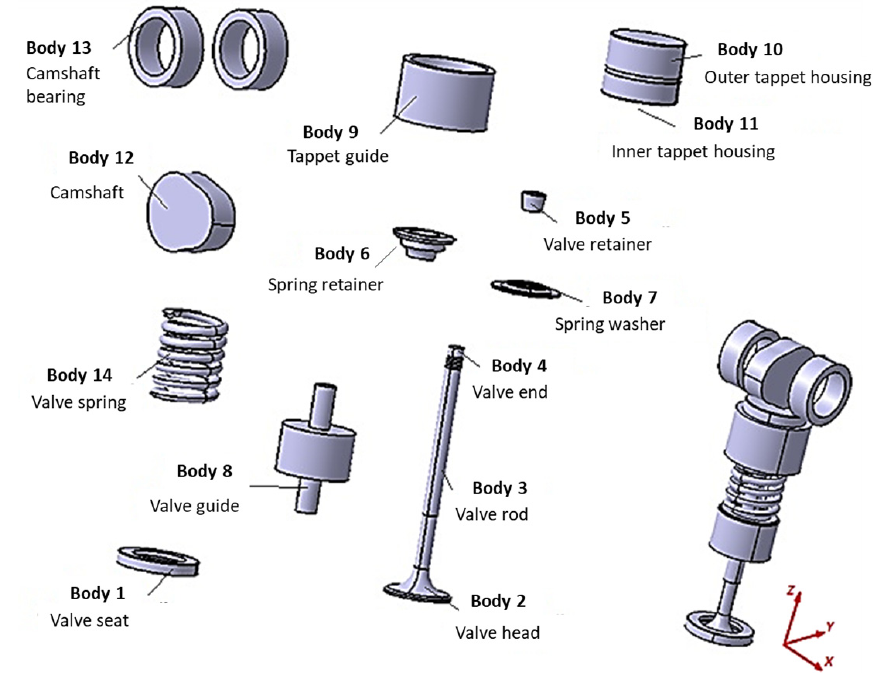
Figure 2. 3D Modelling of the valvetrain system’s components.